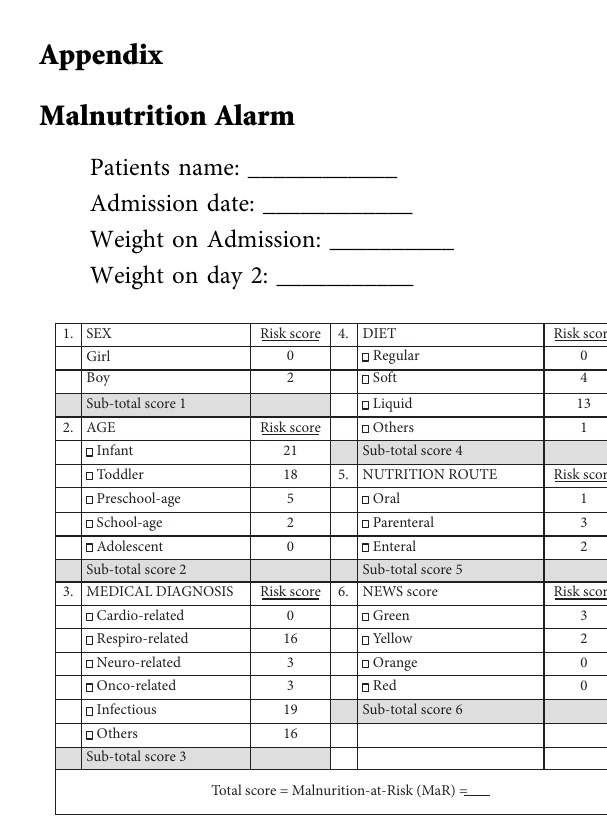
Table 7: Malnutrition alarm score based on the logistic regression coefficient for risk factors or characteristics.